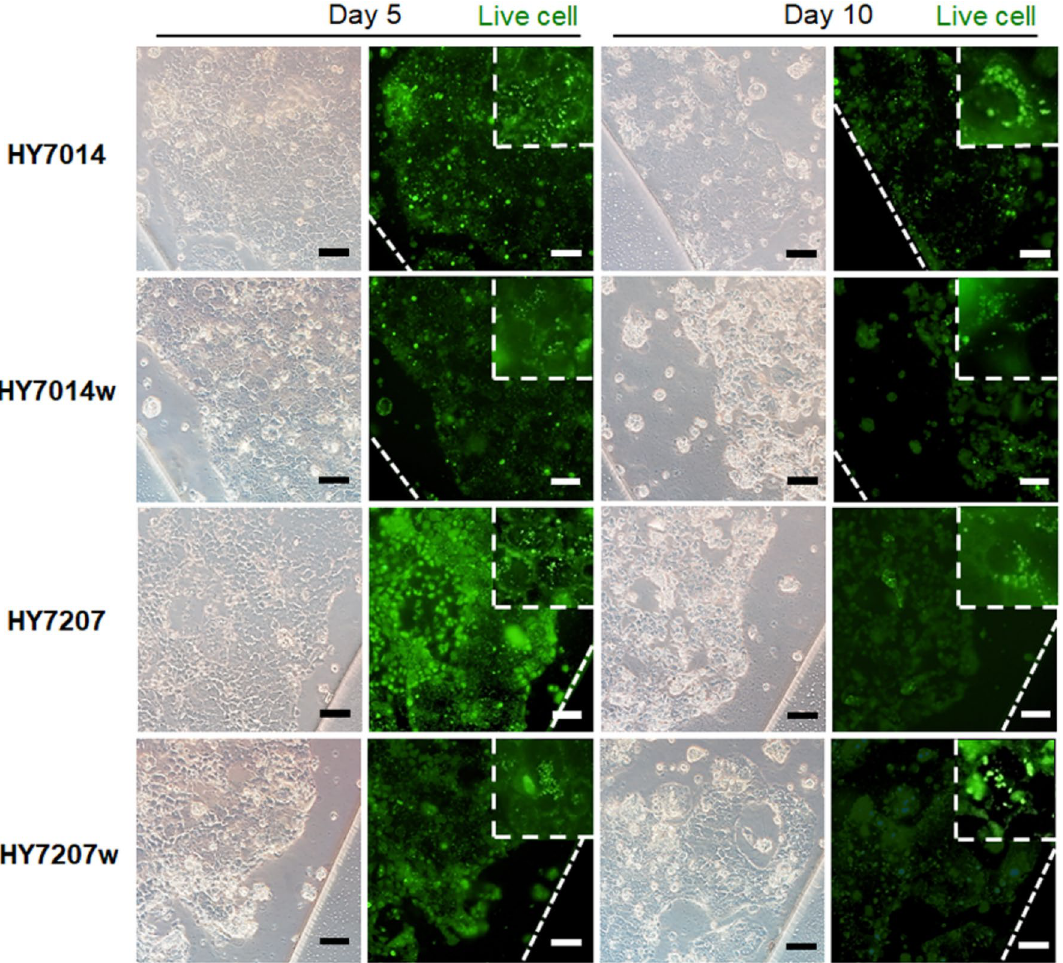
Fig. 3 Microbial co‑culture on a human intestinal epithelial layer in a gut‑liver axis chip. Both wild type and experimental microbial were cultured on the surface of an epithelial layer grown within a gut‑liver axis chip (HY7014 and HY7207 probiotic; HY7014w and HY7207w as a control of the wild type; seeding density 1 10 9 CFU/mL). Green fluorescence views from above of probiotics and Caco‑2 cell co‑cultured for 5 and 10 days at × low and high (white‑dotted rectangle) magnification, which shows microcolonies of the microbial (green spots) that remain tightly adherent to the apical surface of the epithelial layer after exposure to continuous fluidic flow. Scale bars are 100